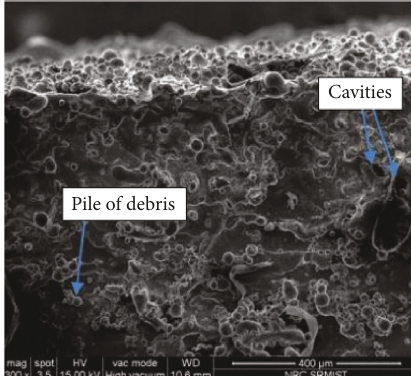
Figure 7: Machined surface using zinc-coated tool with 600x